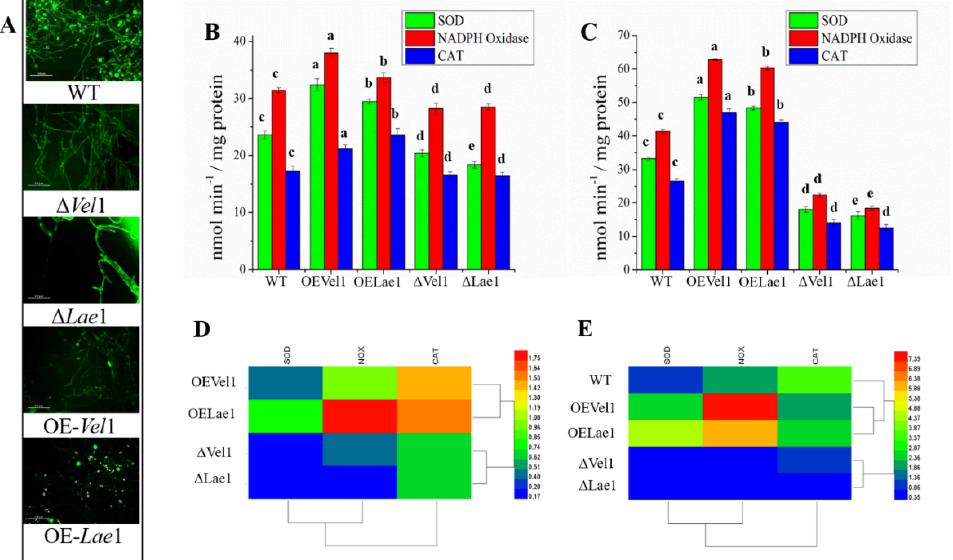
Figure 1. The reactive oxygen species production and oxidative stress response of T. asperellum WT, OE Vel1 , OE Lae1 , Δ Vel1 , and Δ Lae1 under salinity stress. ( A ) ROS production under saline stress. ( B ) Antioxidant activity under normal conditions. ( C ) Antioxidant activity under saline stress. ( D ) The relative expression of antioxidant genes (SOD, CAT, and NOX) under normal conditions. ( E ) The relative expression of antioxidant genes during saline stress (SOD, CAT, and NOX). Results were showed in terms of fold changes compared to the WT strains grown under normal conditions. Values are the average of biological triplicates. Error bars represent the standard error. Bars with different letters represent a statistically significant difference from each other at the level of p < 0.05 based on the